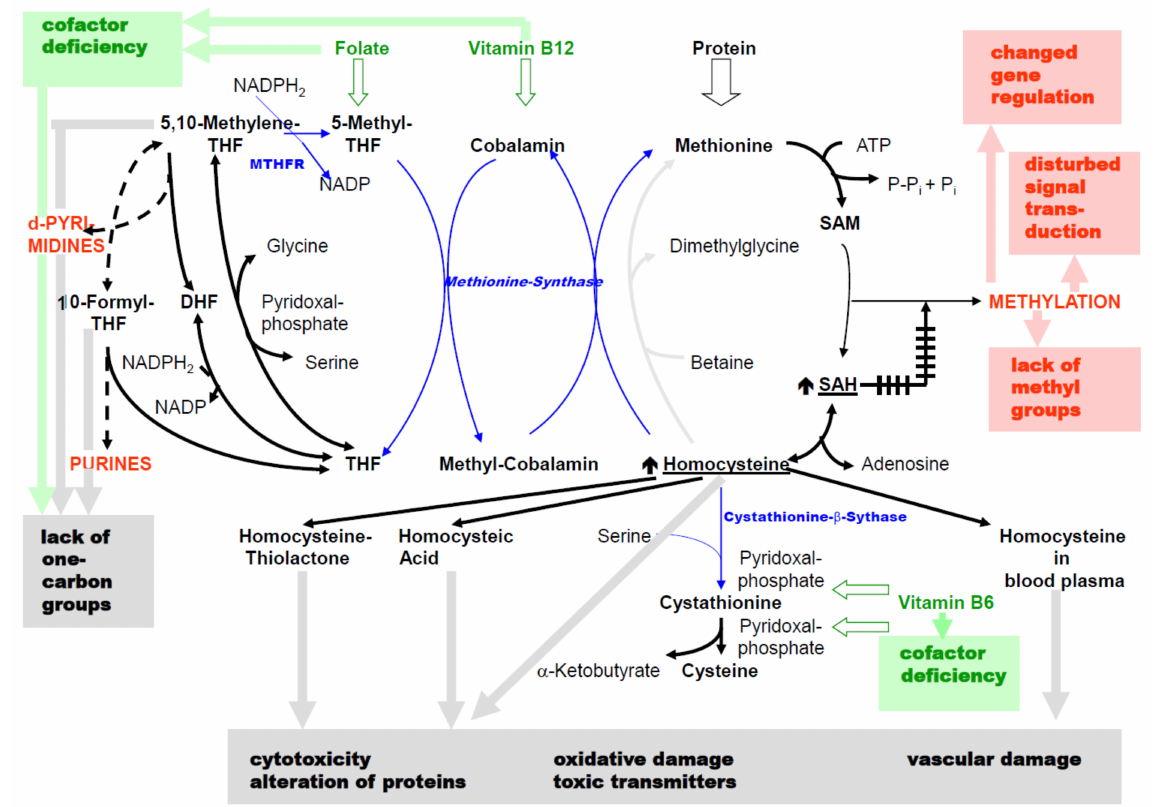
Figure 3. Adaption of the previous chart (colors and abbreviations: see Figure 1 caption): pathogenic effects of metabolites or products in the context of disorders in C1